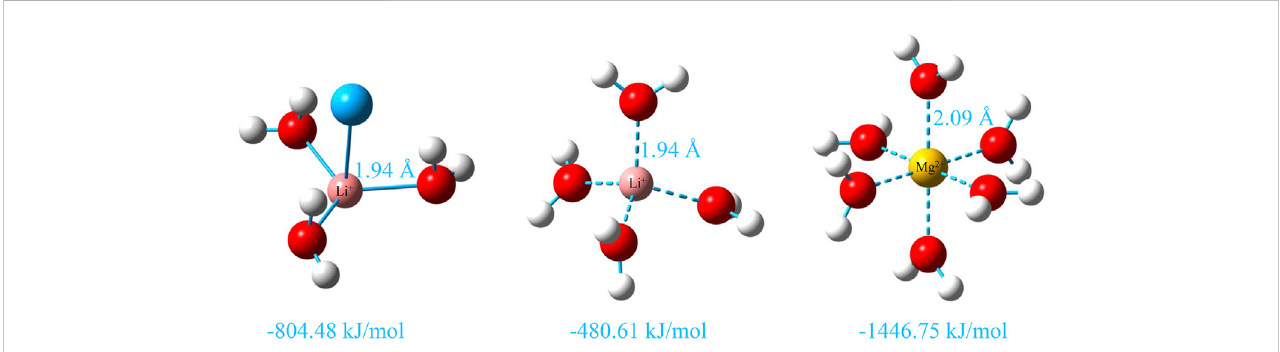
FIGURE 5 Hydration structures of Li + and Mg 2+ at the B3LYP/def2-TZVP level (Weigend and Ahlrichs, 2005) and corresponding counterpoise corrected binding energy of Li + and Mg 2+ with the O atom in water molecules calculated at the PWPB95/def2-QZVPP level (Weigend and Ahlrichs, 2005; Zheng et al., 2011) by ORCA 5.0.3 software (Neese et al., 2020; Neese, 2022), and the D3(BJ) correction and diffuse function are added to all calculations (Grimme et al., 2010; Grimme et al., 2011).